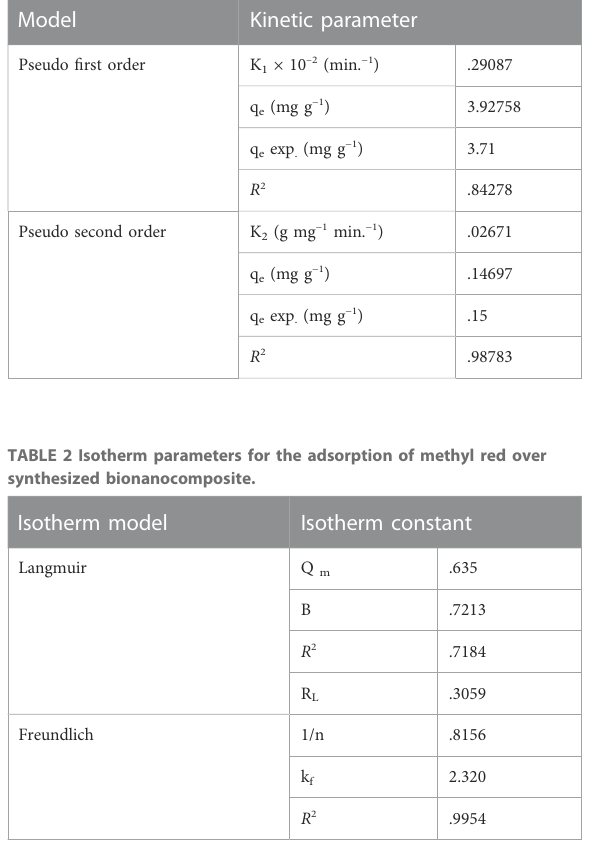
TABLE 1 Kinetic parameters for the adsorption of methyl red over synthesized bionanocomposite. Model